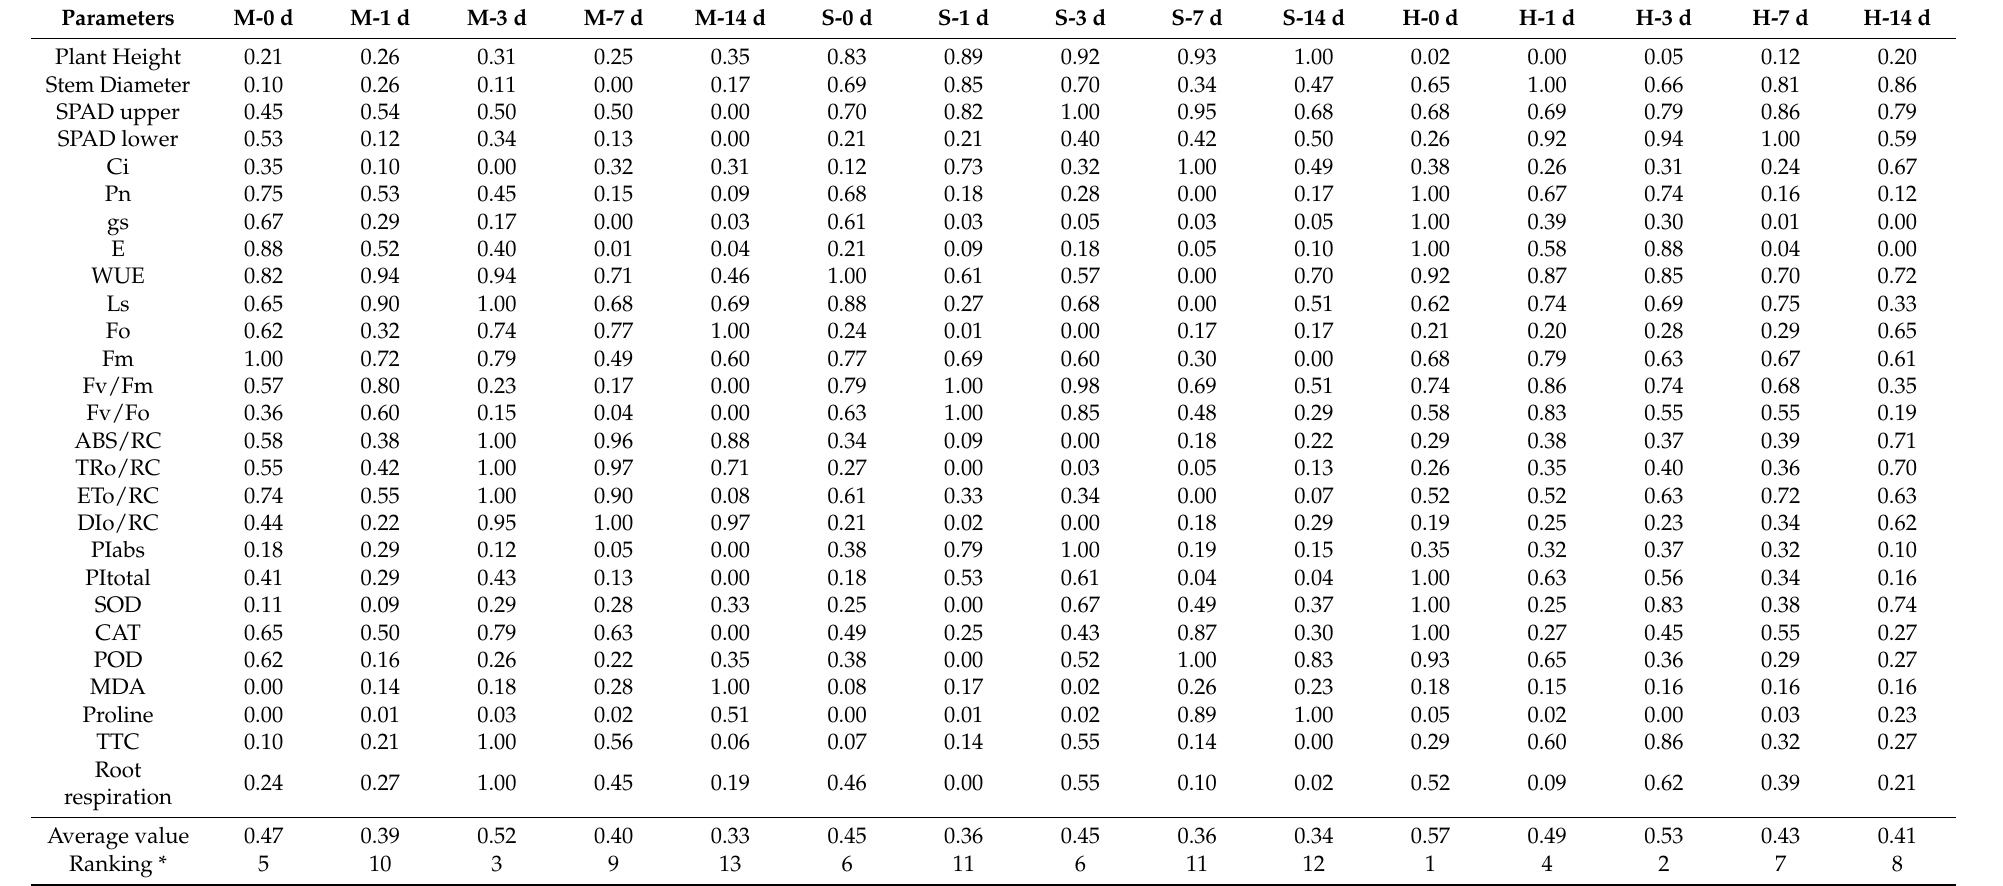
Table 6. Evaluation of waterlogging tolerance of different peach rootstocks based on membership function